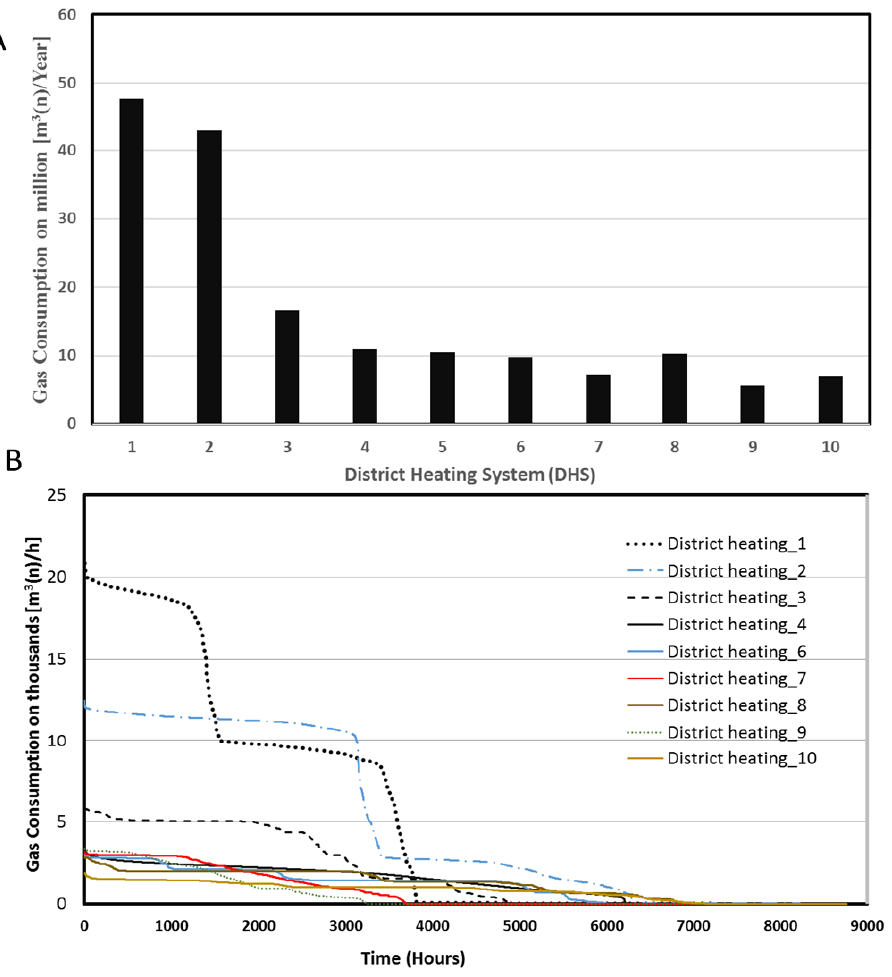
Figure 2. Gas consumption trend by district heating system (DHS). ( A ) Yearly consumption; ( B ) Consumption rate for one year, when data are treated in descending order.